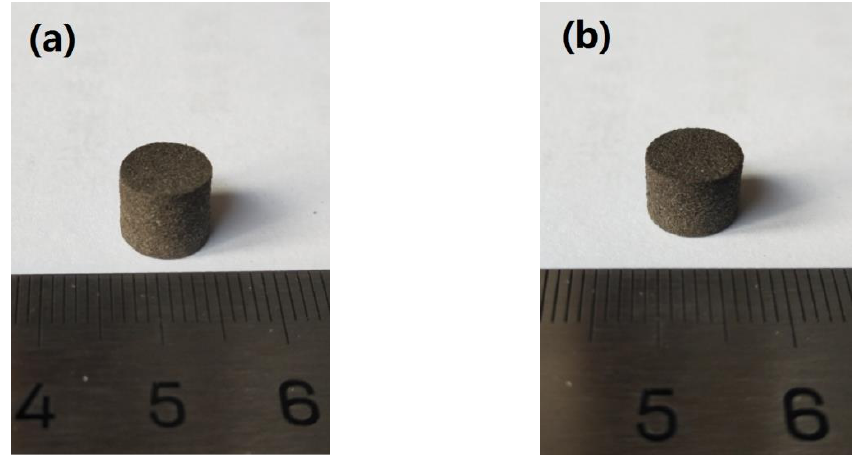
Figure 1. Photographs of two sizes of machined specimens for the ( a ) low-strain-rate loading test and ( b ) high-strain-rate loading test.